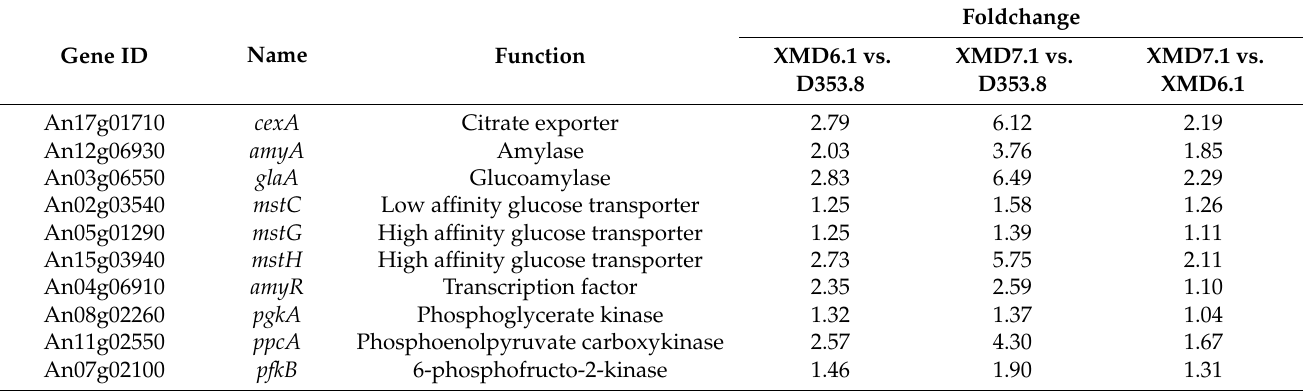
Table 2. Differentially expressed genes involved in central metabolism in P gpdA :: cexA